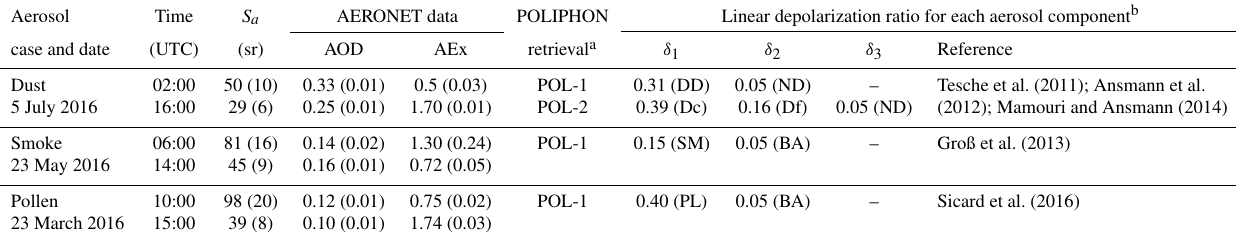
Table 2. Aerosol cases observed over BCN on selected days. AERONET data at particular times of the event (as shown in Figs. 4, 6 and 8), including those KF-retrieved LR values ( S a ), and parameters used in the POLIPHON retrieval algorithm, depending on the version applied. References for the assumed particle linear depolarization ratio for specific components δ i (either i = 1–3 or i = 1, 2, depending on the case) are also included. Errors are shown in parentheses.